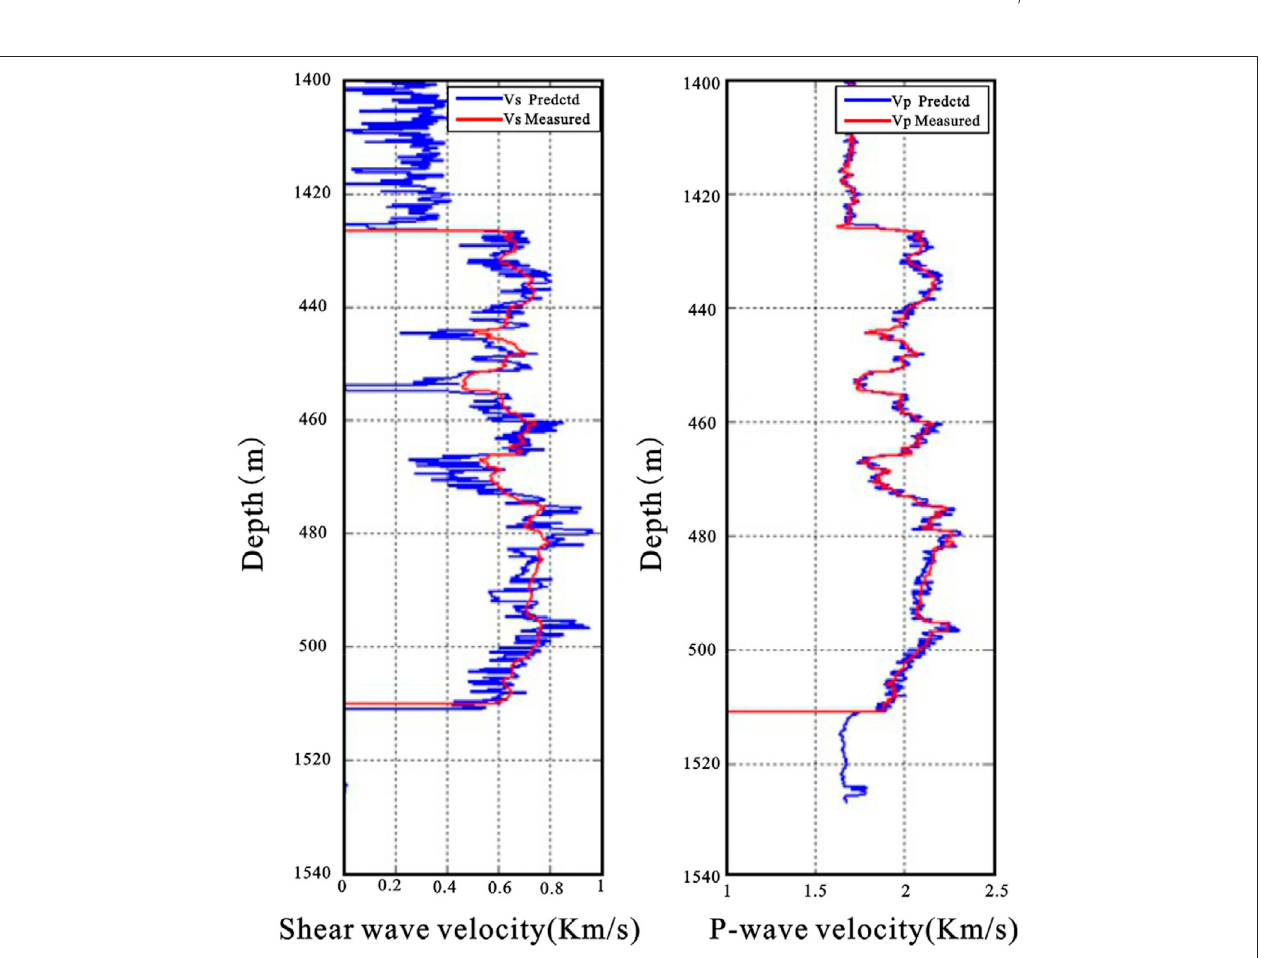
FIGURE 10 | Prediction results of S-wave velocity based on dual phase hydrate model.